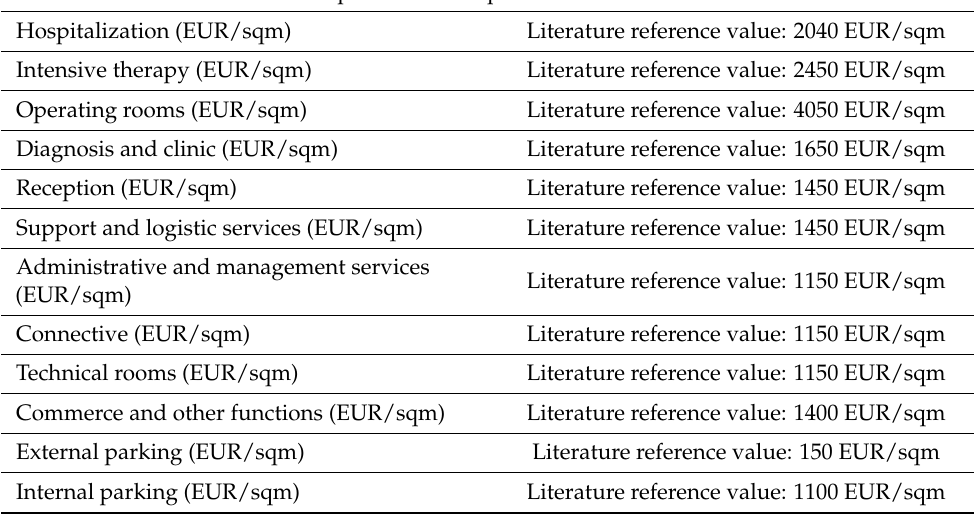
Table A4. Building box pluri-parametric construction costs. In this section, it is required to insert a value in EUR/sqm for each category, according to own experience in hospital